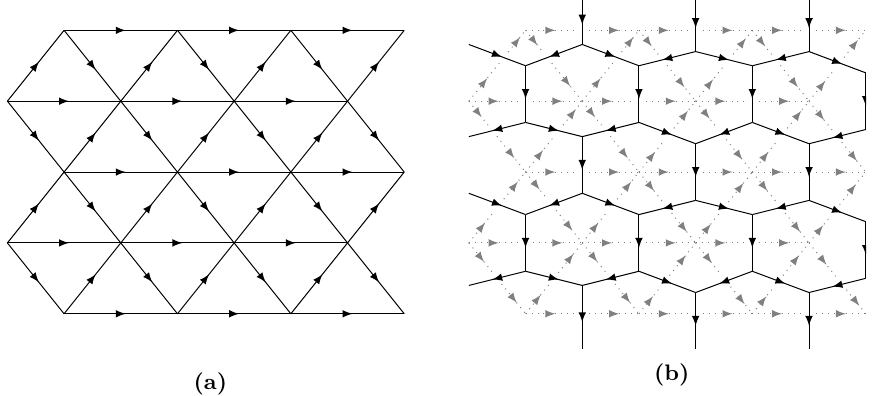
Figure 4 . For the triangulation Γ in (a), we define the dual graph ˜Γ in (b) in which the direction of each dual edge is a π/ 2 clockwise rotation of the corresponding edge in Γ